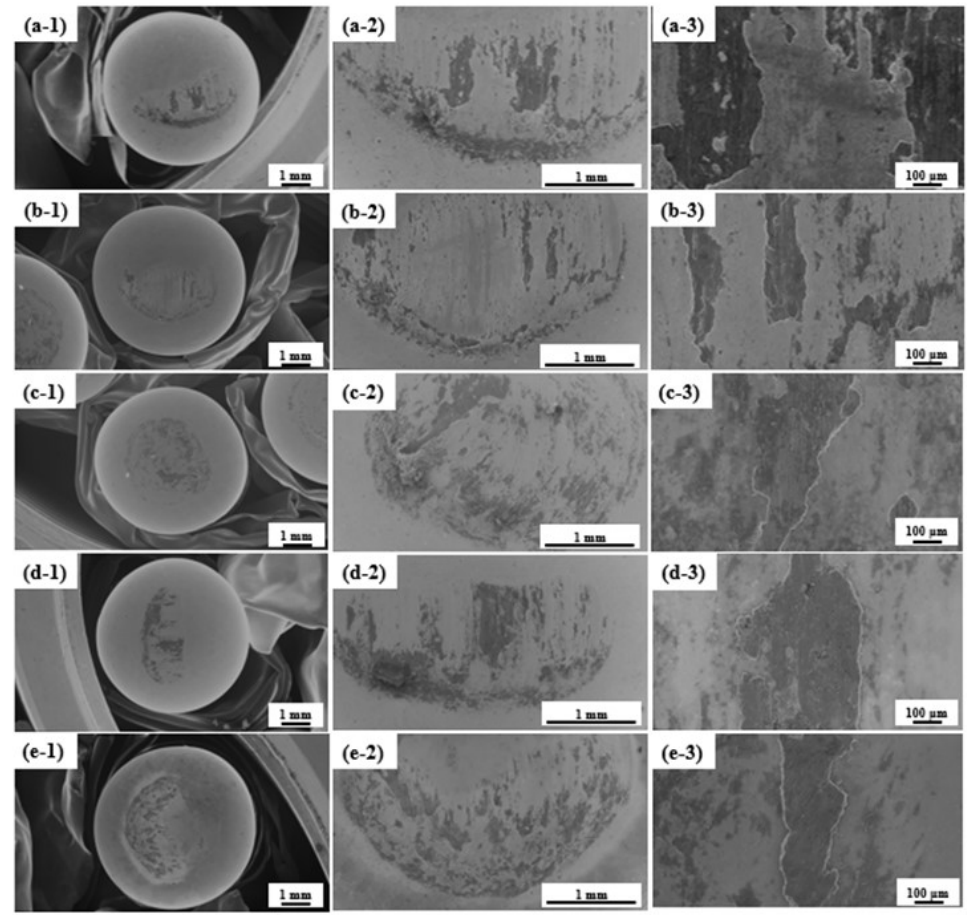
Figure 17. Steel pins used in coating wear test: 0 ( a ), 1 ( b ), 2 ( c ), 3 ( d ), and 4 ( e ) g/L TiO 2 .